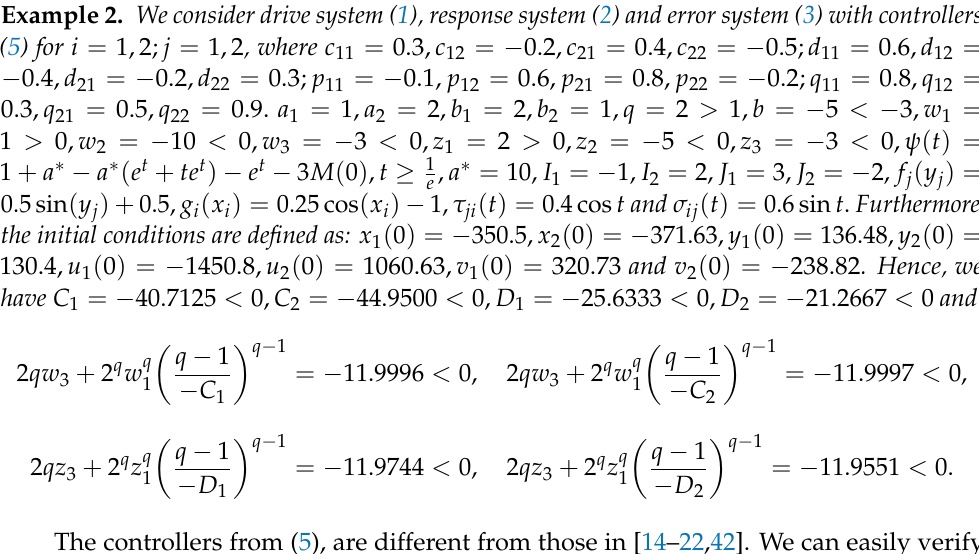
Figure 3. The curves of e 1 ( t ) , e 2 ( t ) , r 1 ( t ) , r 2 ( t ) from Example 1.